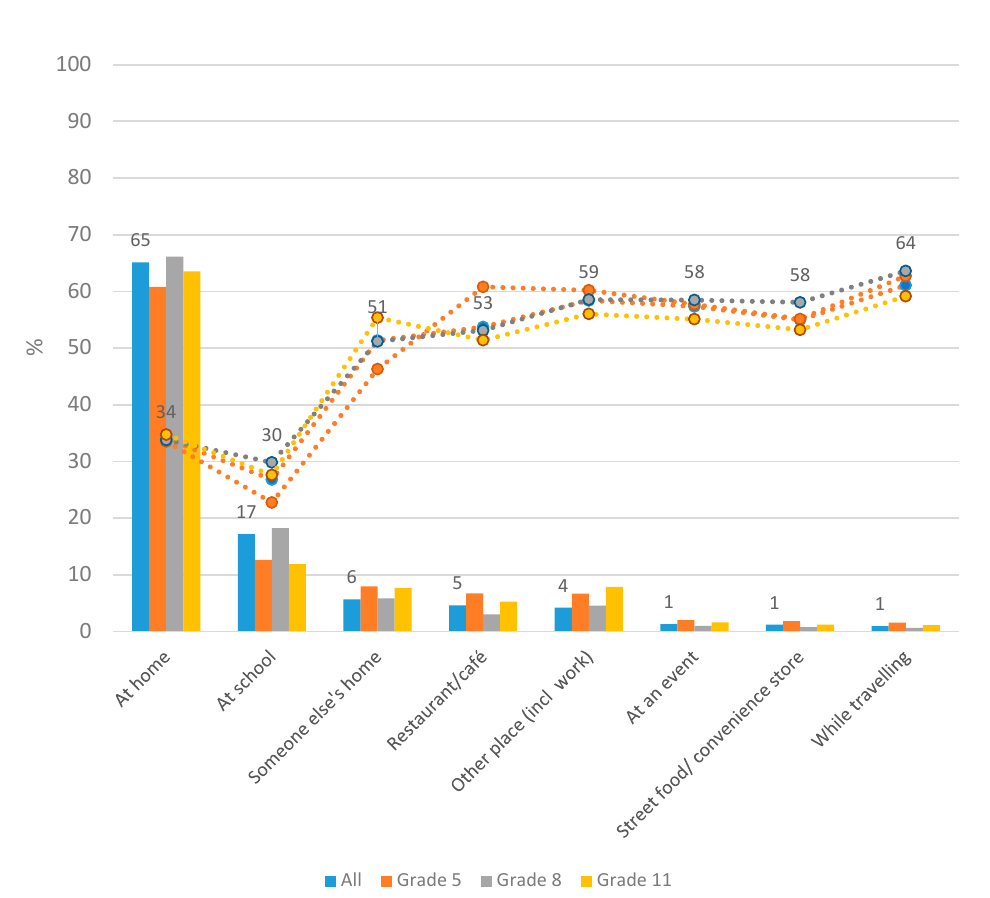
Figure 1. Food/beverage consumption by location. Number of food/beverages consumed, expressed as a proportion of total energy, at each location ( bars ), and number of food/beverages consumed at that location that are discretionary, expressed as a proportion of all energy consumed at that location ( lines ). Provided data labels are for “All”.